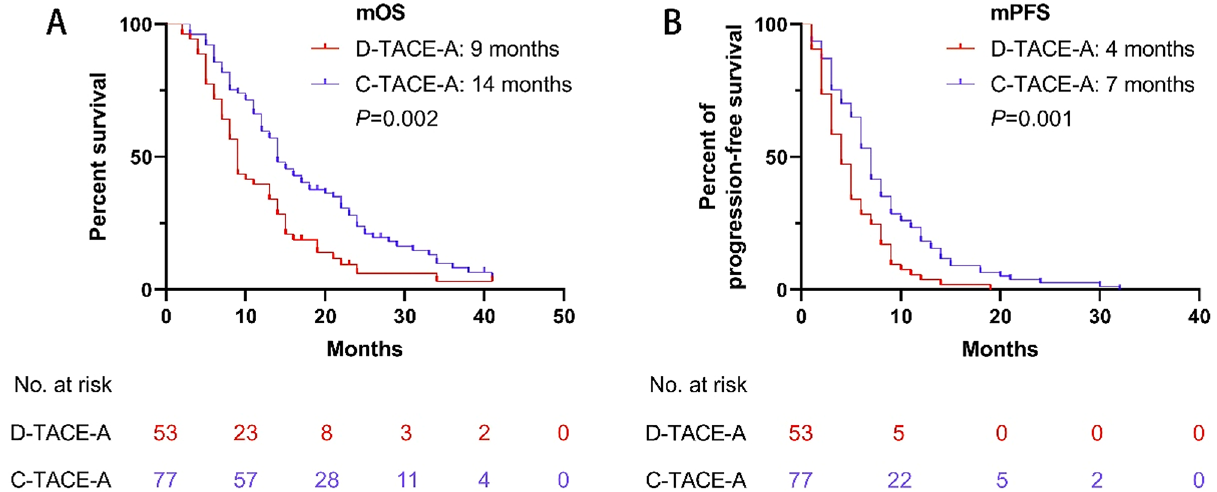
Figure 2. Kaplan–Meier curves of overall survival and progression-free survival in the patients before PSM. ( A ) Kaplan–Meier curve for overall survival; ( B ) Kaplan–Meier curve for progression-free survival.